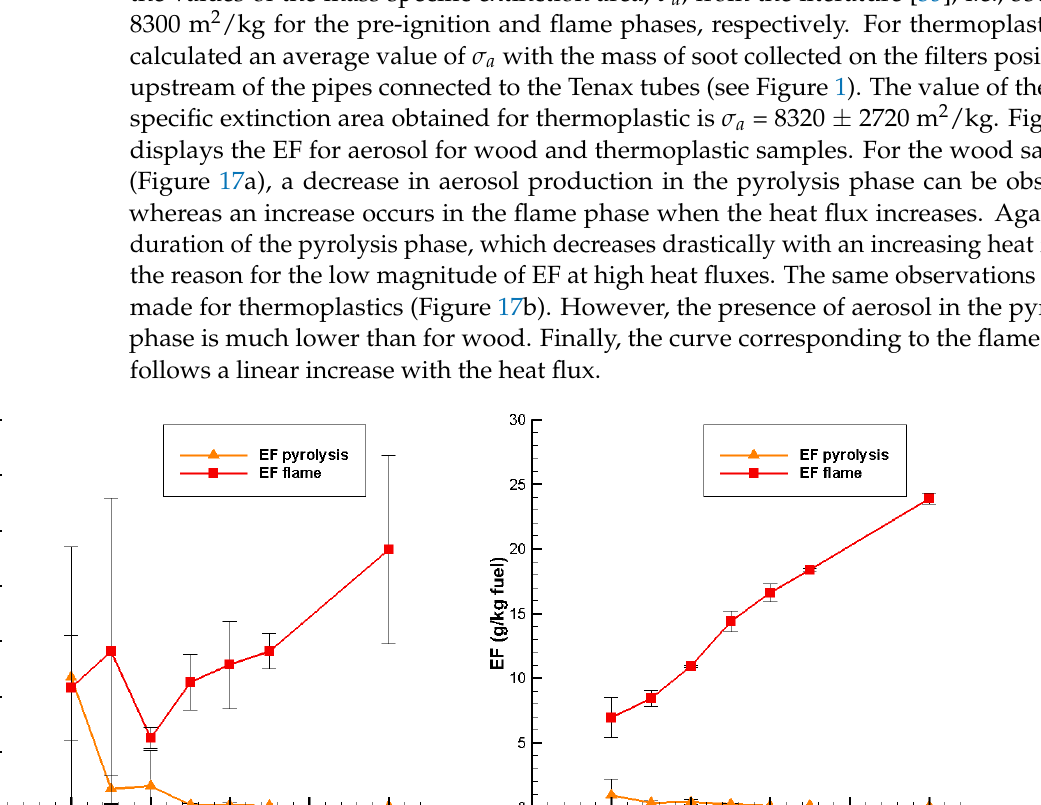
Table 4. EF for VOCs and SVOCs of wood samples.